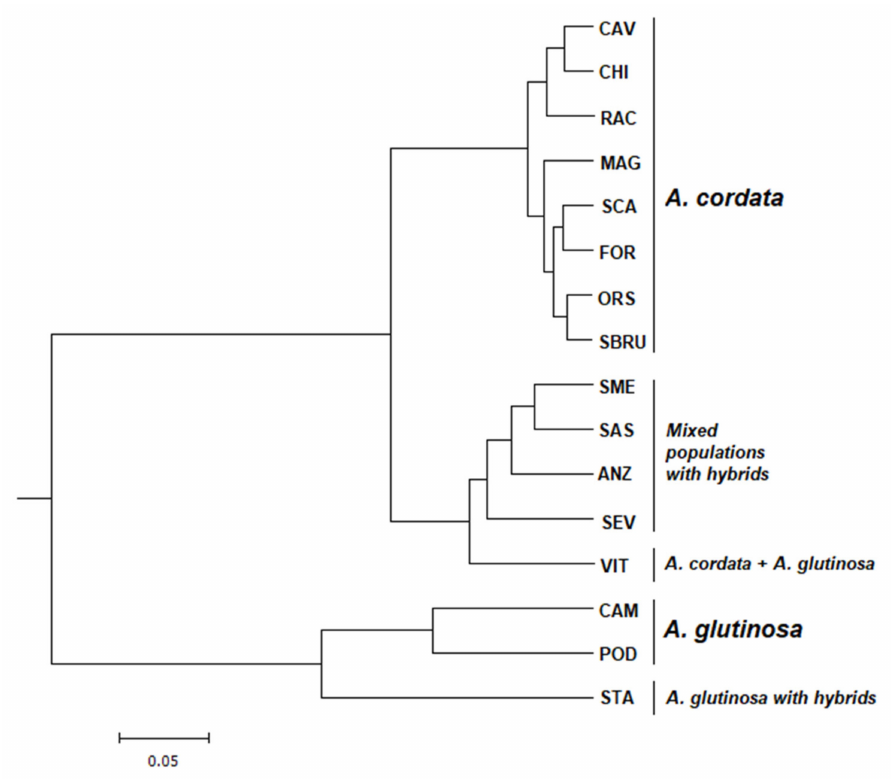
Figure 6. UPGMA cluster analysis based on Nei’s genetic distances between pure and mixed populations of A. cordata , A. glutinosa and